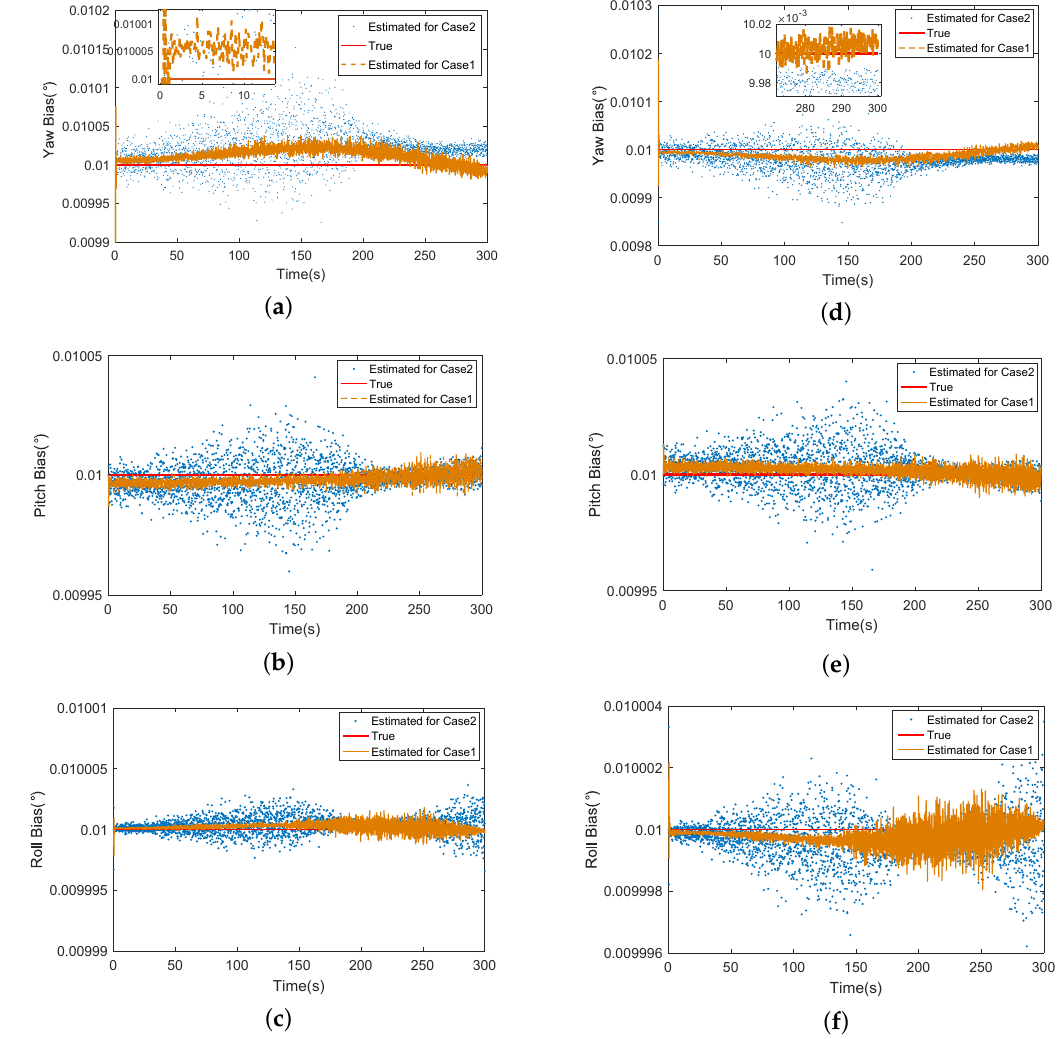
Figure 7. ( a ) The estimation of yaw bias of missile 1; ( b ) The estimation of pitch bias of missile 1; ( c ) The estimation of roll bias of missile 1; ( d ) The estimation of yaw bias of missile 2; ( e ) The estimation of elevation error of pitch bias of missile 2; ( f ) The estimation of roll bias of missile